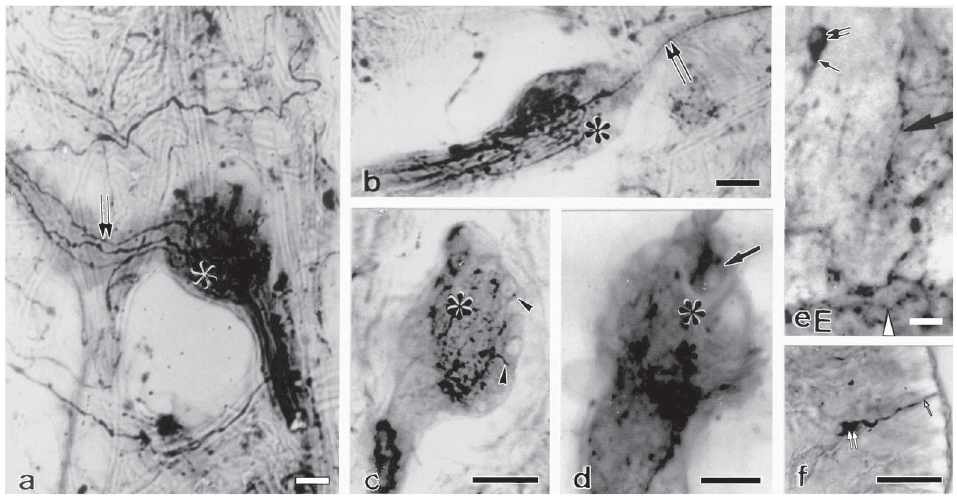
Figure 4. Photomicrographs of foot section of Megalobulimus oblongus. a and b , Detail from the pedal plexus showing a ganglion with an intensely 5- hydroxytryptamine (5-HT) im- munoreactive neuropil (aster- isks). Observe 5-HT immunore- active fibers (double arrows) that enter or exit the ganglion. c , Ganglion showing positive axons (arrowheads) surround- ing negative neuronal somata. d , Ganglion displaying a 5-HT immunoreactive neuronal soma (arrow). e , Transverse section from ventral region of the foot. Positive varicose axon (arrow) above the muscle cells and in the subepithelial plexus (arrow- head) over the epithelium (E). Note a serotonergic neuronal soma (double arrow) and its pro- cess (thin arrow). f , Ventral epi- thelium of foot. Observe a 5-HT immunoreactive neuronal body (double arrow) and its distal pro- cess (arrow) traveling between two epithelial cells. Bars: a-f = 20